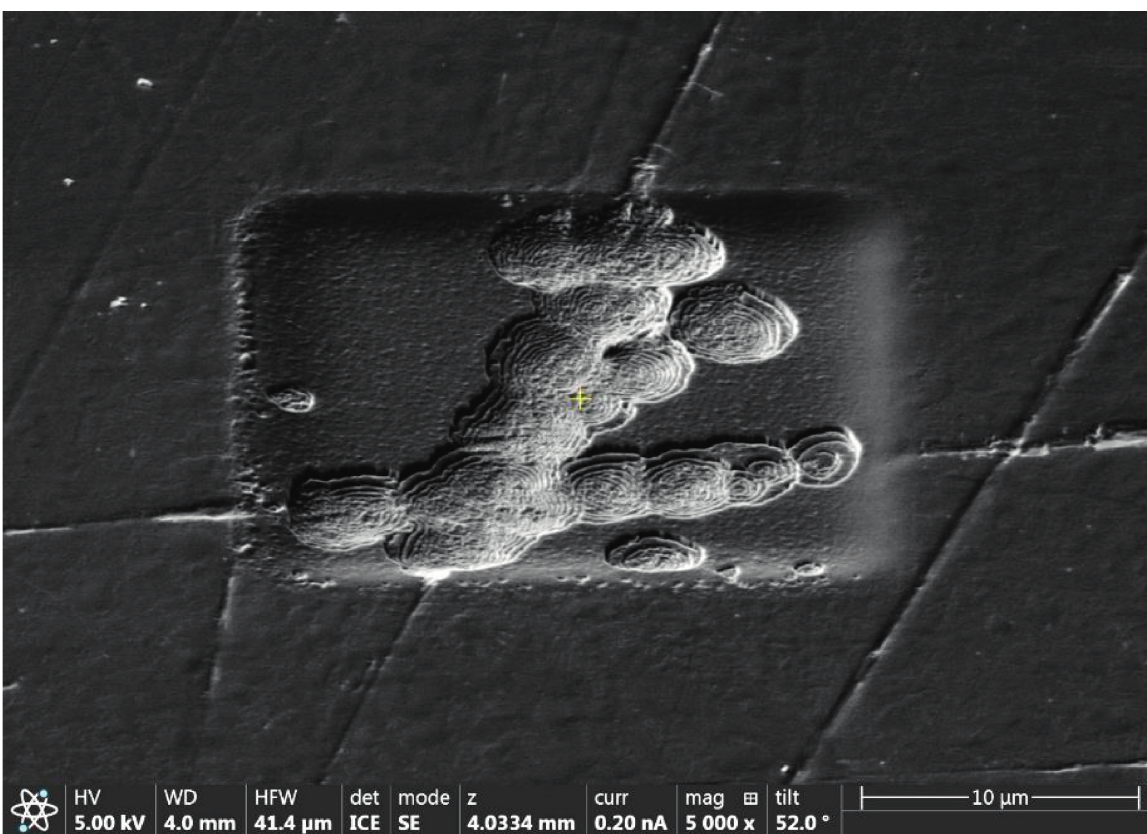
Figure 8: Titanium milled with O + at 30kV.